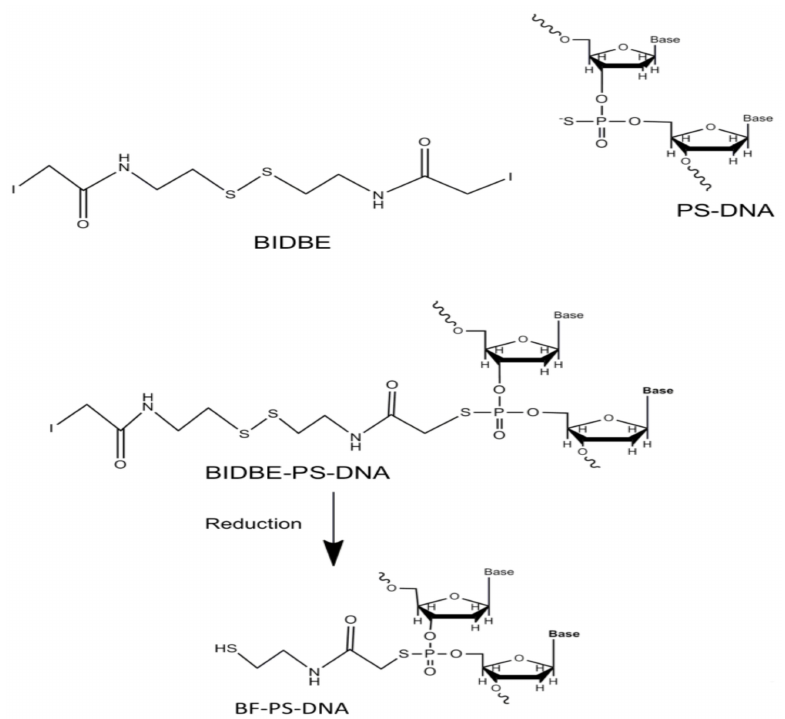
Figure 37. BIDBE binds to BIDBE-PS-DNA (phosphorothioate) to form the bi-functional linker (BF), associated with PS-DNA (bifunctional linker). BF supplies an au-NP sulfhydryl group. Reprinted with reference authorisation [233], Copyright 2007, WILEY-VCH.